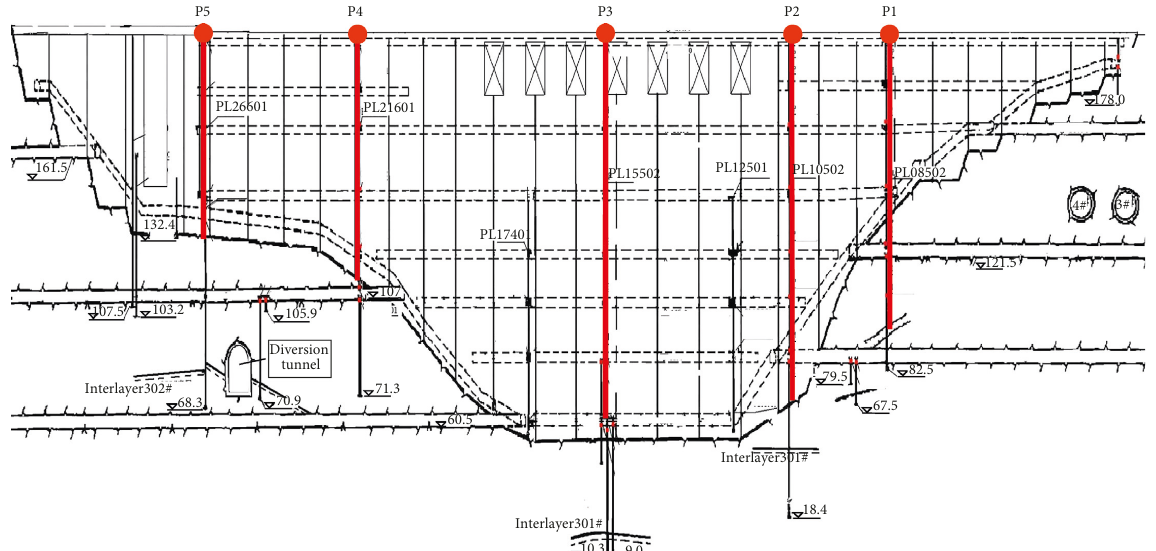
Figure 16: Distribution of inverted plumb line points at the top of the dam (the red dot indicates the inverted point of the dam crest).